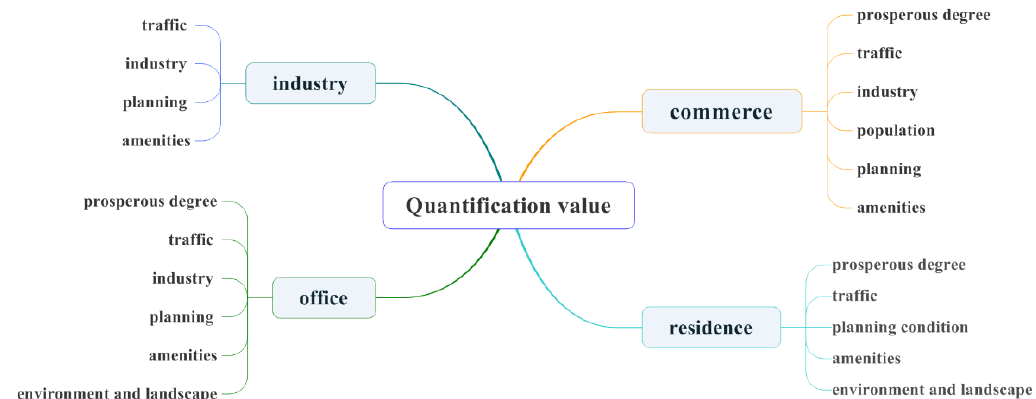
Figure 3. Quantification system.